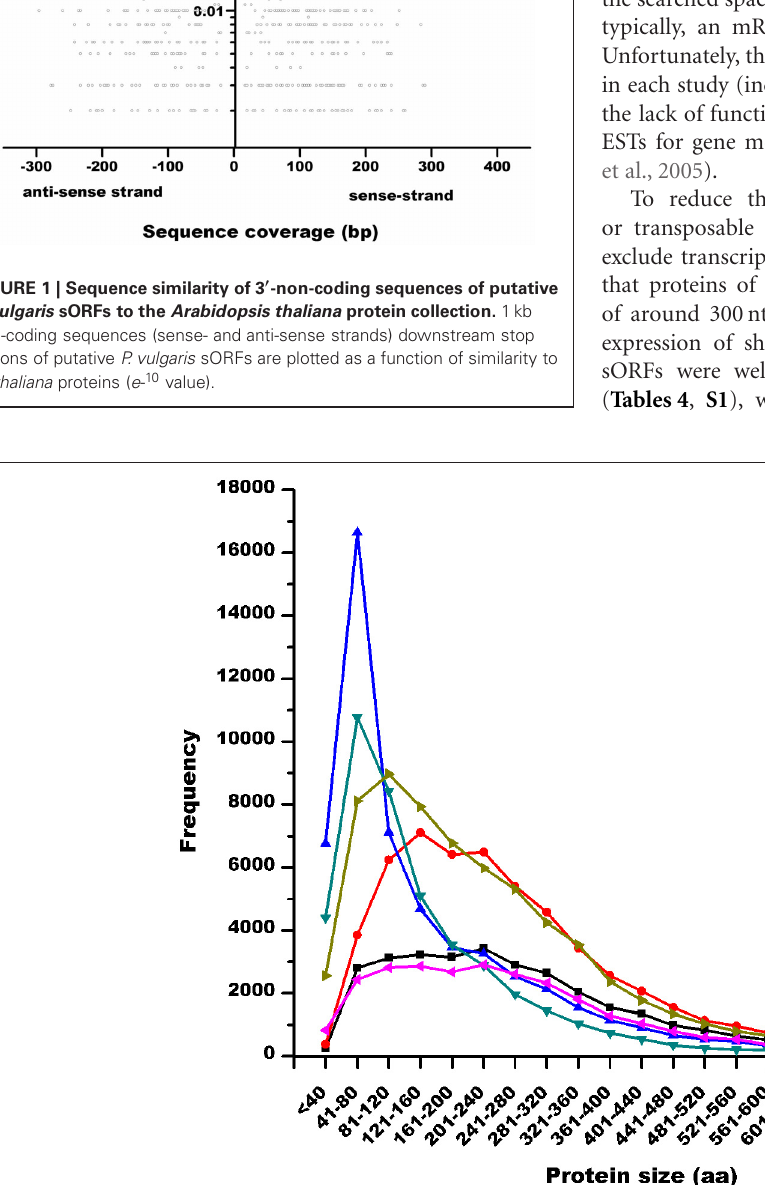
FIGURE 2 | Length distribution of predicted protein sequences in legume and non-legume plant genomes. Pv, Phaseolus vulgaris protein sizes in P. vulgaris v0.9 annotation; Gm, Glycine max protein sizes in G. max v1.0 annotation; Mt, M. truncatula protein